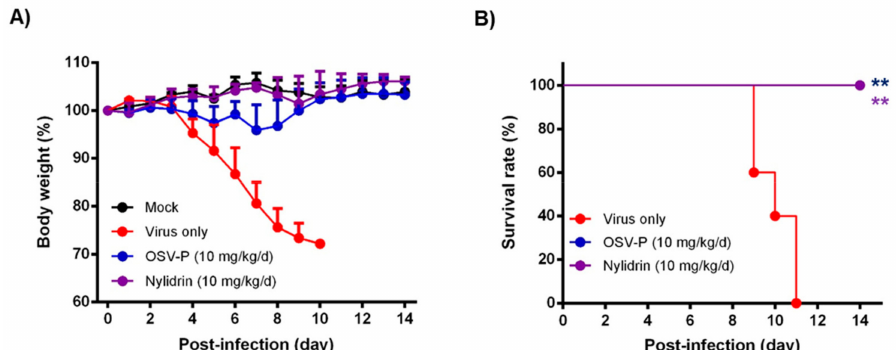
Figure 5. In vivo antiviral activity of nylidrin against a mouse-adapted influenza A virus (H1N1), maPR8. Before viral challenge, maPR8 (5 MLD 50 ) was preincubated with DMSO (virus only) or with nylidrin (10 mg / kg) at room temperature for 30 min. Mice were mock-infected or infected with the preincubated samples. As a positive control, OSV-P (10 mg / kg / day) was orally administered twice a day beginning 4 h before virus infection at 8-h intervals from days 0 to 5 post-infection. Body weight ( A ) and mortality ( B ) were measured every day for 15 days. Statistical analysis was performed using a two-tailed unpaired t -test relative to the virus-only group. n = 5; **, p <